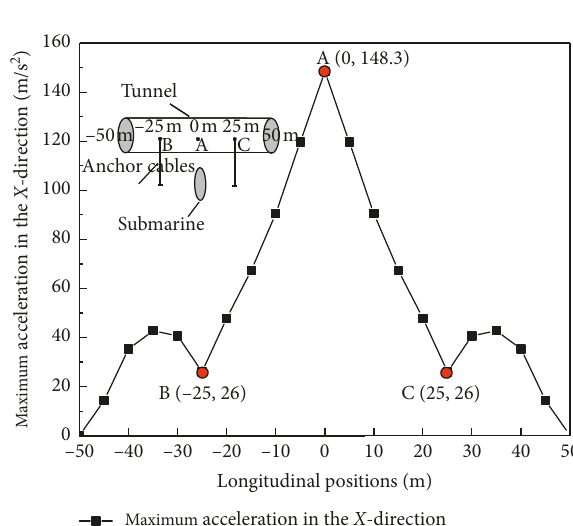
Figure 15: Time-history curve of X -direction acceleration at point